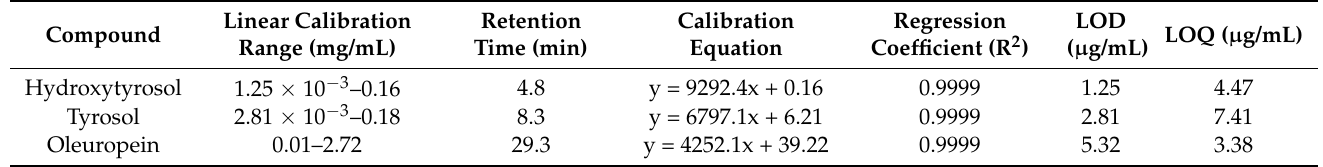
Table 1. Analysis of phenolic compounds derived from olive